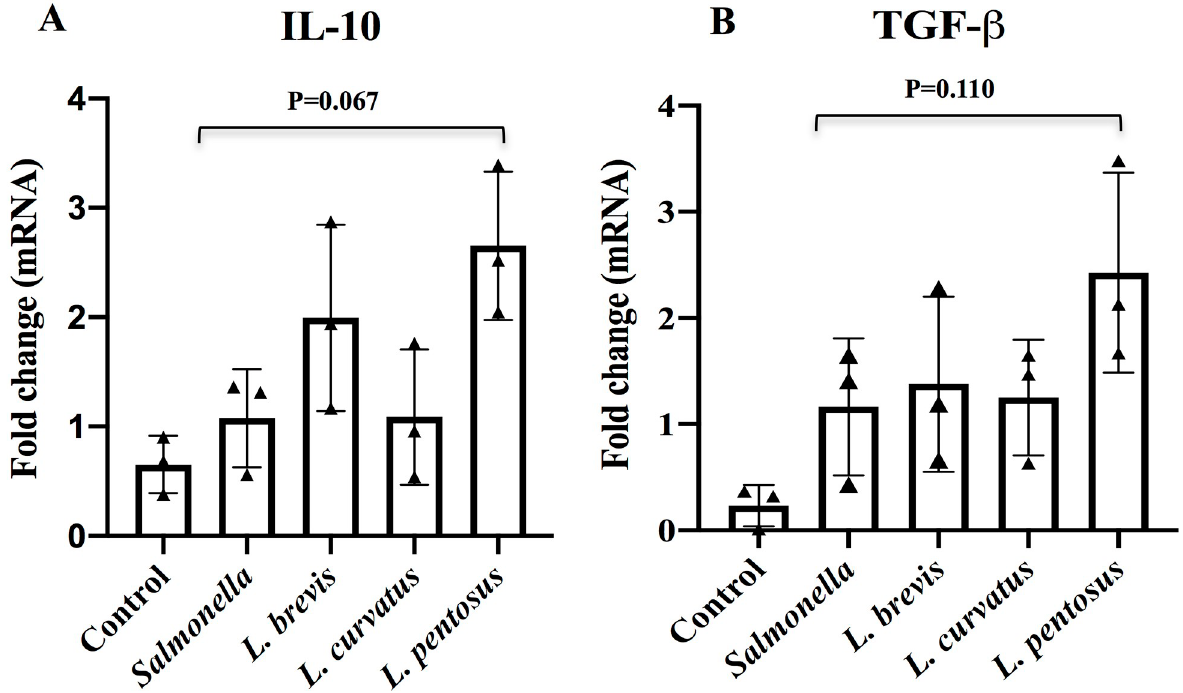
Fig 6. Lactobacillus strains ability to increase regulatory cytokines expression in HT-29 cells co-cultured with PBMCs. Apical HT-29 cells were stimulated with LABs for 48h, followed by stimulated with Salmonella for 12 h. The expression of IL-10 (A) and TGF- β (B) were analyzed by RT-PCR. Cells treated either with medium or Salmonella alone were used as controls. The results represented here is an average values (mean ± S.D) of three independent values. Significant differences between the groups, � p <